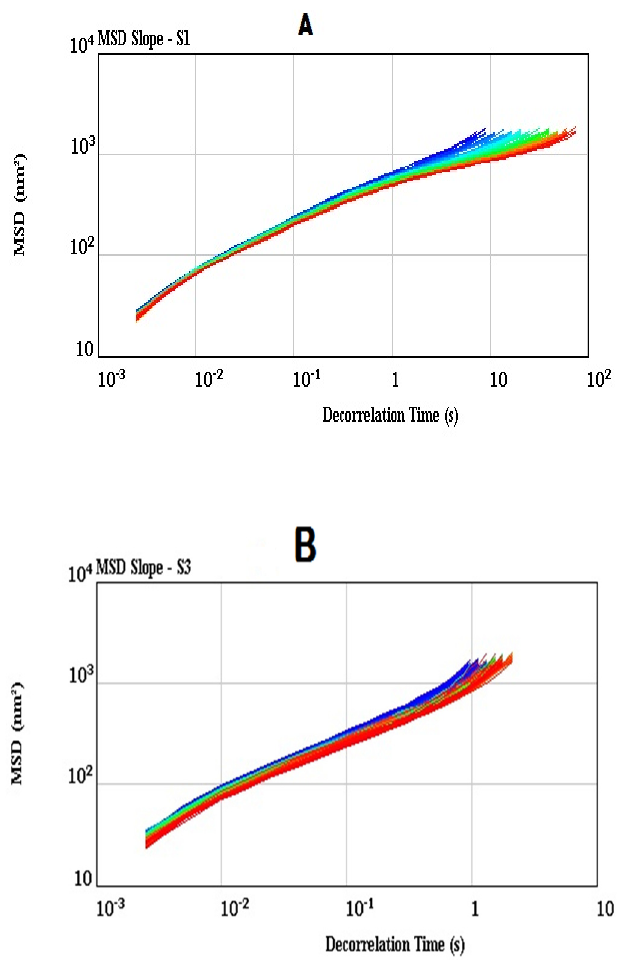
Figure 5. Mean square displacement (MSD) ( A for S1, B for S3).